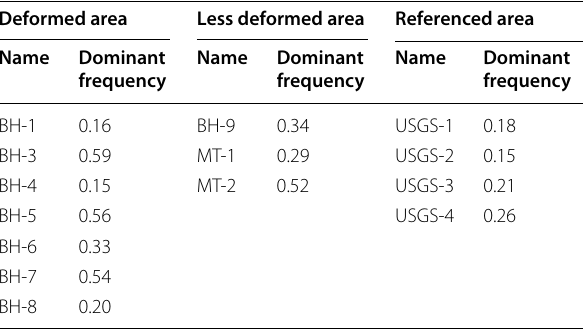
Table 1 Dominant frequency at the observation sites Deformed area Less deformed area Referenced